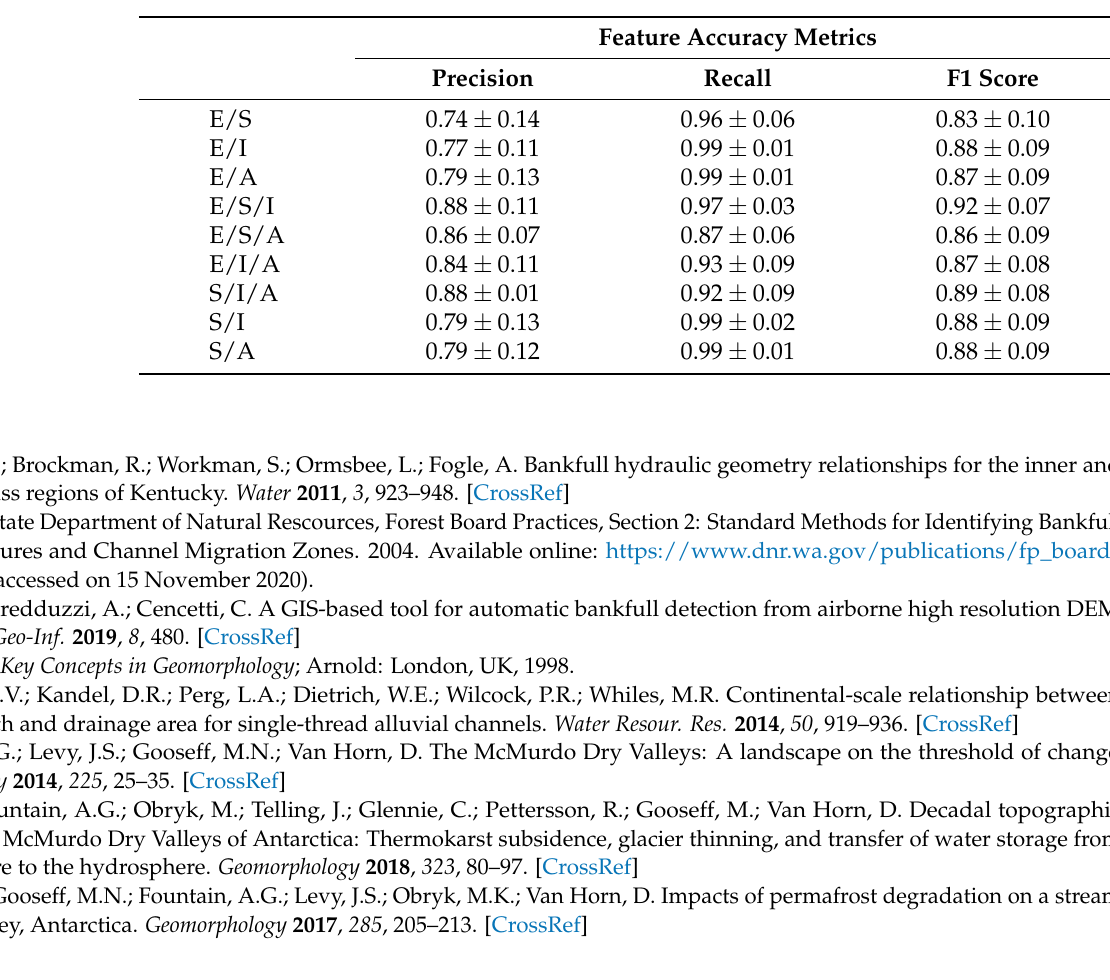
Table A1. Prediction performance of stream boundary detection for the different feature combinations: elevation (E), slope (S), intensity (I), and flow accumulation